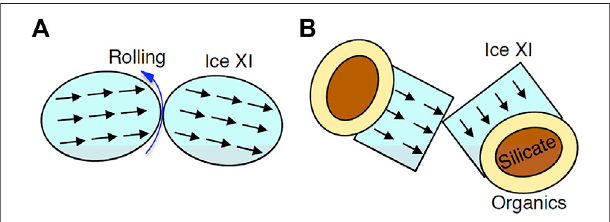
FIGURE 9 | Schematic illustrations on the collision of ice XI grains. (A) SphericaliceXIgrainshavebeenassumedinpaststudies(e.g.,Wangetal.,2005). Black arrows show direction of dipole. Kinetic energy of collision is expected to dissipate by the rolling (blue arrow). (B) Our model of ice XI polyhedral single crystal-attached to refractory grain (core: silicate, outer mantle: organic materials).